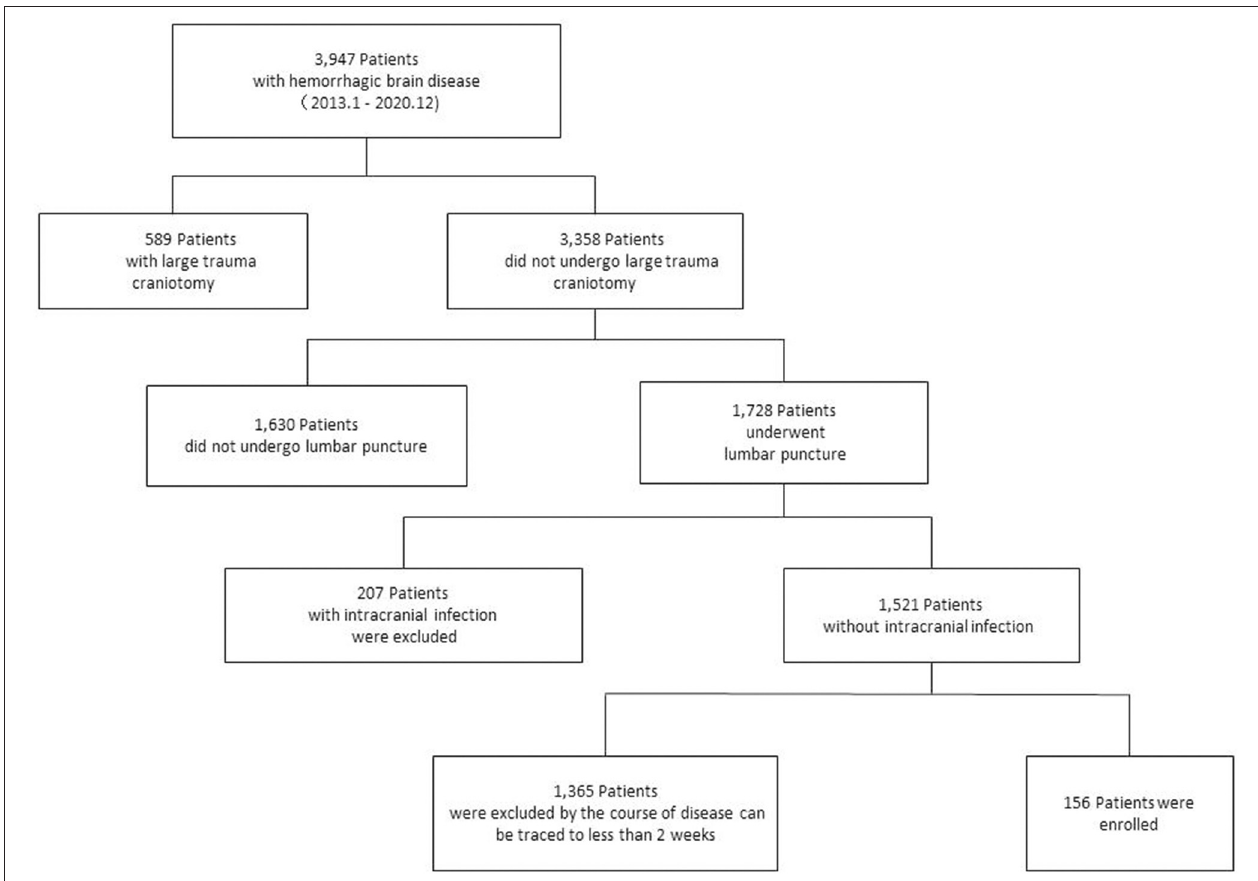
FIGURE 1 | Case inclusion process. A total of 3,947 patients with hemorrhagic brain diseases were treated in our hospital, and 156 patients were selected for retrospective